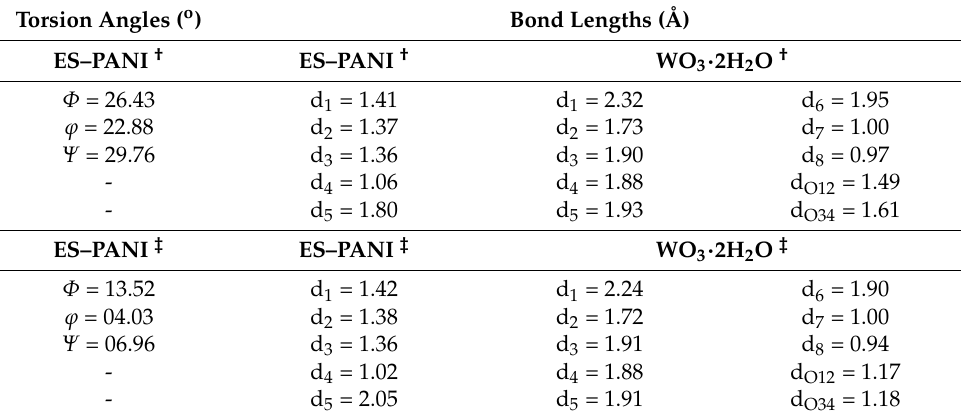
Table 1. Bond lengths and torsion angles of the PWO nanocomposites and their individual phases. Torsion Angles ( o